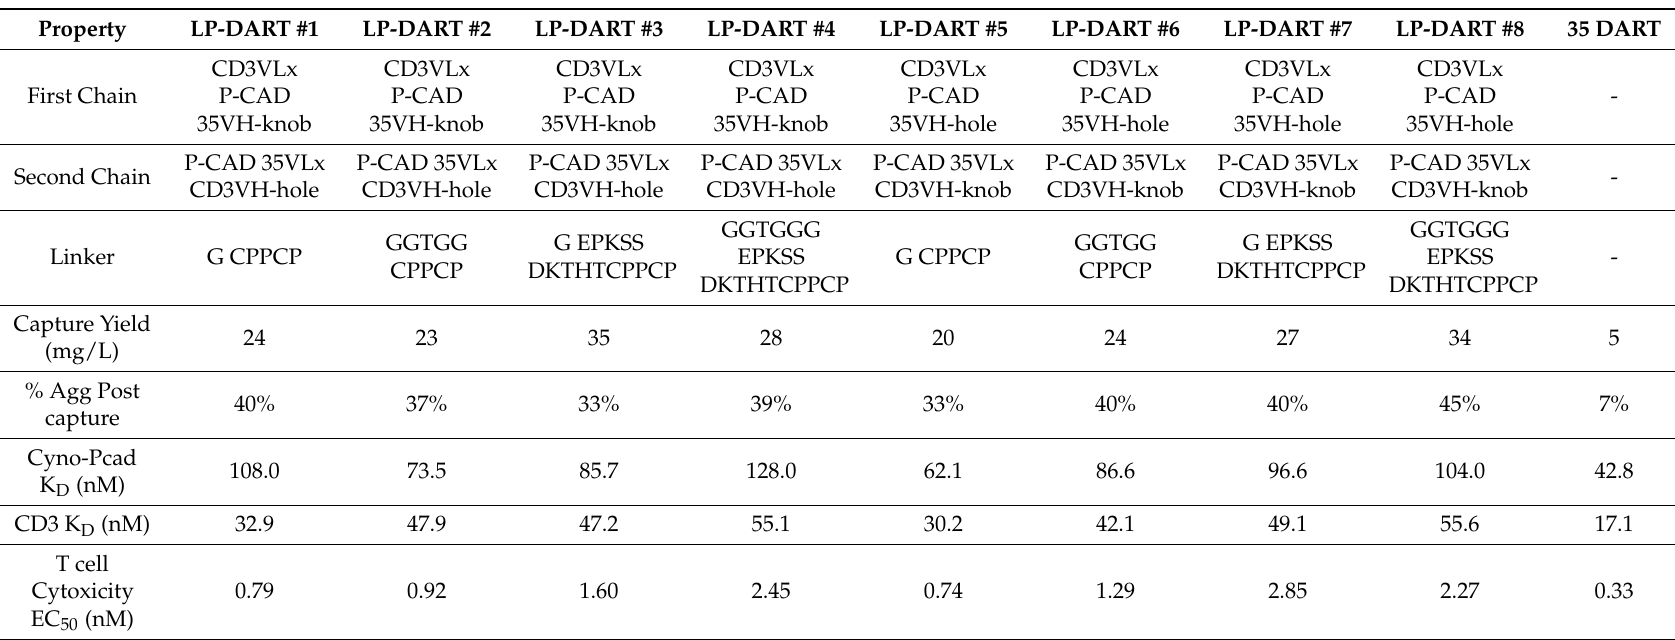
Table 4. Biophysical and functional properties of LP-DART proteins. The optimal format for the Fc-containing DART was determined by varying the linker length (between diabody and Fc) and swapping the orientations of variable domains with corresponding knob and hole Fc domains. Linker sequences preceding the hinge sequence CPPCP are shown in bold. LP-DARTs were transiently expressed and evaluated for expression level, purity following affinity capture, equilibrium binding constants to cynomolgus P-cadherin and human CD3 epsilon, and CTL cytotoxicity. Capture Yield = total DART protein yield following Protein A capture step, measured in mg/L; % Agg Post capture = percentage of aggregation or HMMS following Protein A capture; Cyno-Pcad K D (nM) = equilibrium dissociation constant measured by Biacore against cynomolgus monkey P-cadherin captured on the chip; CD3 K D (nM) = equilibrium dissociation constant measured by Biacore against human CD3 captured on the chip; T cell Cytoxicity (nM) = redirected cytotoxic T lymphocyte killing EC 50 value on NCI-H1650 cells incubated with resting T cells for 18